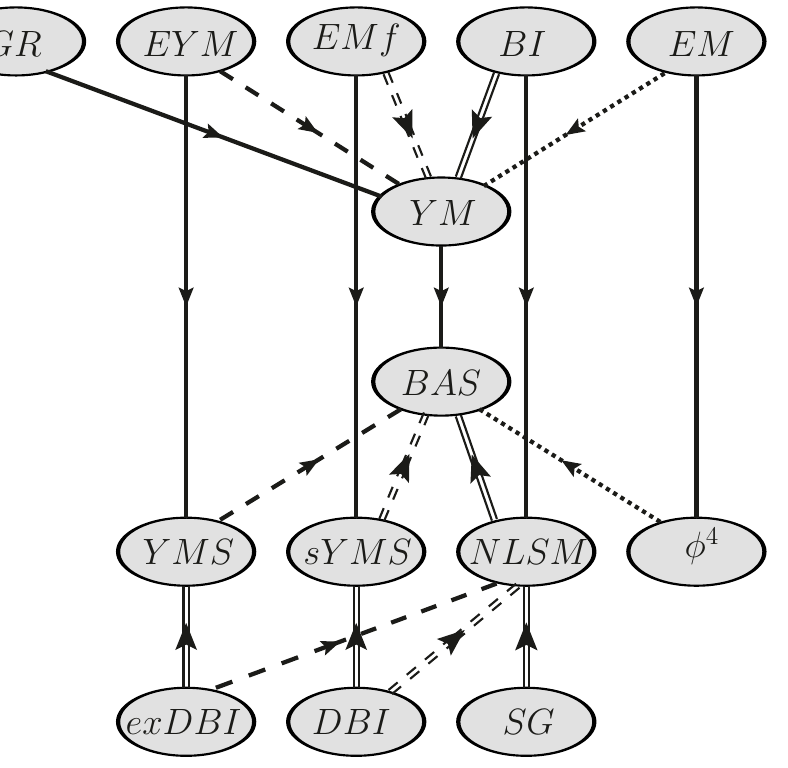
Figure 1 . Uni(cid:12)ed web for